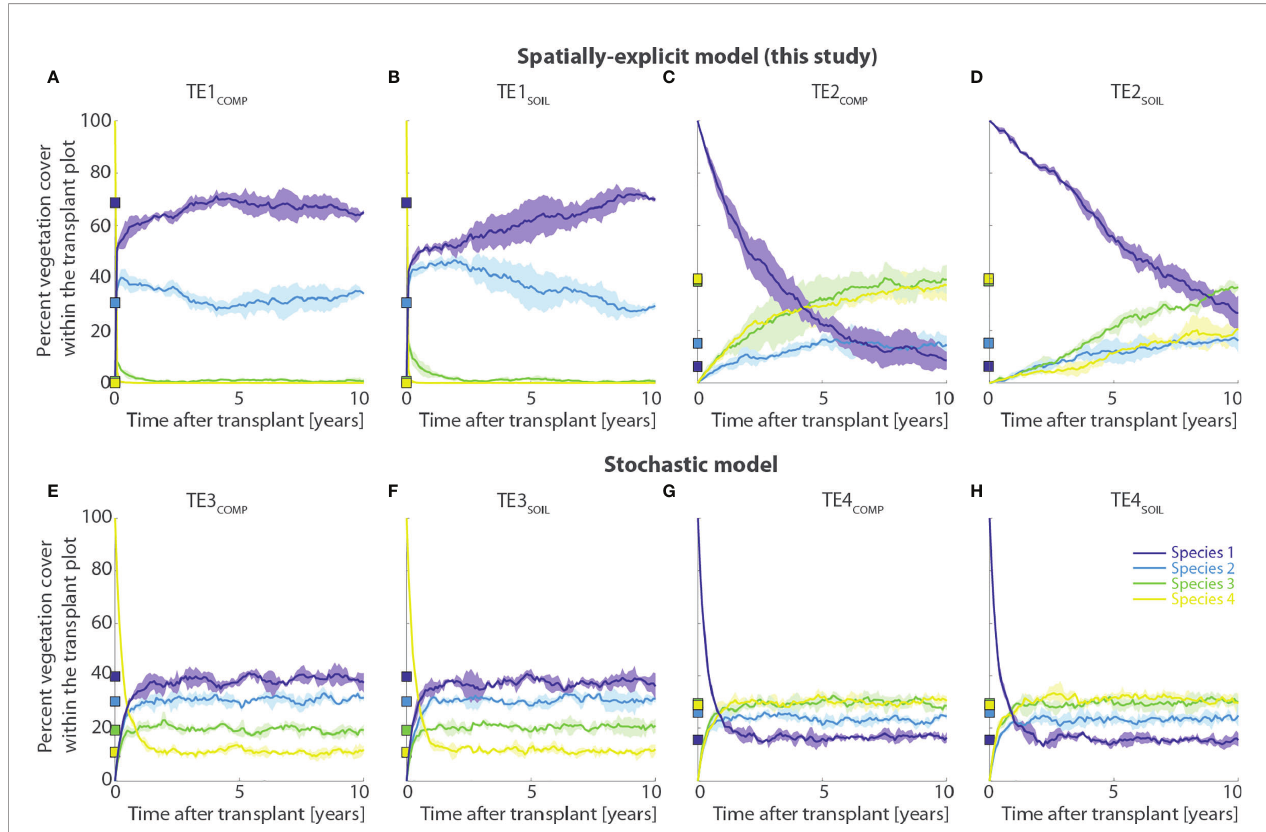
FIGURE 9 | Results of transplant experiments of marsh halophytes outside their realized ecological niches (TE simulation series). Each panel shows changes in percent vegetation cover through time within a 20-by-20 m transplant plot. The fi rst row displays results obtained using the numerical model proposed in the present study, whereas the second row reports results derived from a stochastic model that does not account for spatially- and density-dependent mechanisms of species competition and dispersal (see Section 2.2.2). Names of numerical simulations are reported above each panel. The subscript “ COMP ” denote simulations in which biotic competition from neighbor sites was allowed within the transplant plot, whereas the subscript “ SOIL ” indicates simulations in which competition was arti fi cially impeded by systematically removing vegetation within a 5-meter-wide buffer layer around the transplant plot. (A, B) Transplant of Species 4 from upper to lower marsh portions using the spatially- explicit model; (C, D) Transplant of Species 1 from lower to upper marsh portions using the spatially-explicit model; (E, F) Transplant of Species 4 from upper to lower marsh portions using the stochastic model; (G, H) Transplant of Species 1 from lower to upper marsh portions using the stochastic model. Each simulation was repeated 20 times to fi lter out oscillations due to demographic stochasticity. Continuous lines represent average values of aggregated simulation results, with shaded areas denoting standard deviations. Squares on the y-axis show the percent vegetation cover prior to the transplant. Different colors denote different vegetation species according to the legend shown in panel (H) . Percent cover of bare soil is deliberately not reported as it never accounted for more than 1% of the total transplant plot